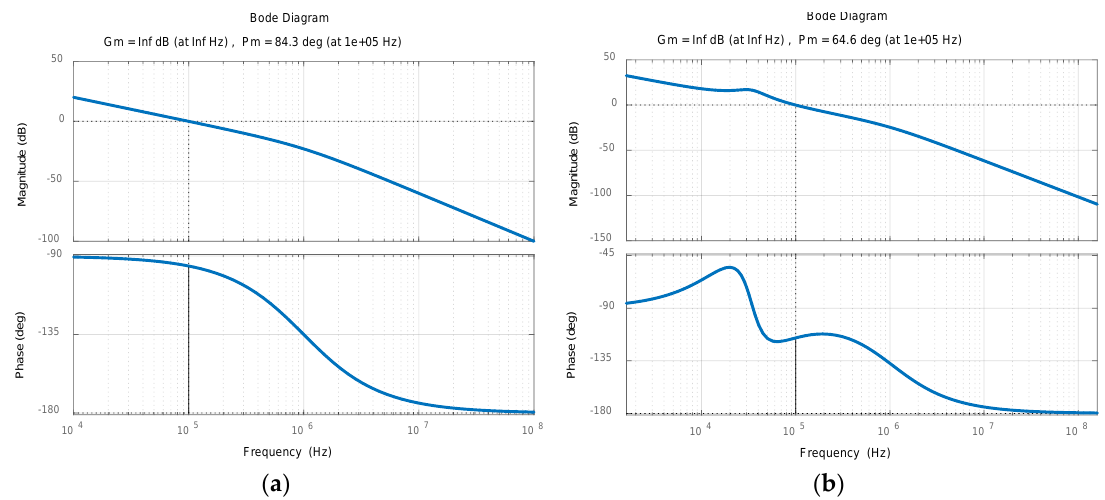
Figure 4. Bode plot of the open-loop compensated system using ( a ) the complex zeros and ( b ) the real zeros.